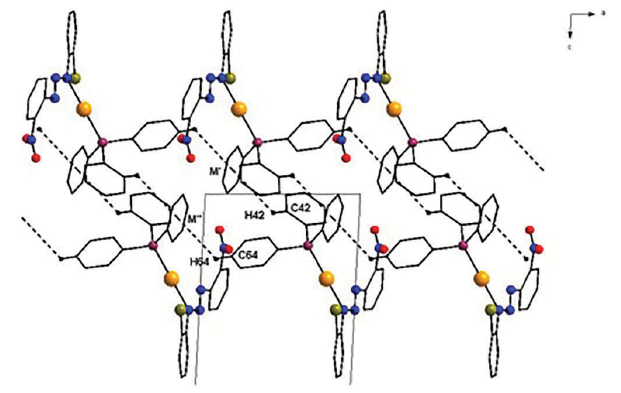
FIGURE 6 - Projection of the supramolecular arrangement of the complex in the crystallographic direction of the axis b, formed by non-classical aromatic hydrogen bondings C54-H54 ∙∙∙ M '' (where M is the centroid point of the aromatic ring C51 '' - C56 '). Hydrogen atoms are omitted for better visualization. Showing partial cell content. [Symmetry code ('): -1 + x, y, z]. TABLE IV - Antibacterial activity profile of (1-(2-bromophenyl)- 3-(2-nitrophenyl) triazenide] (triphenylphosphine) gold (I) against biofilm producing CoNS isolates